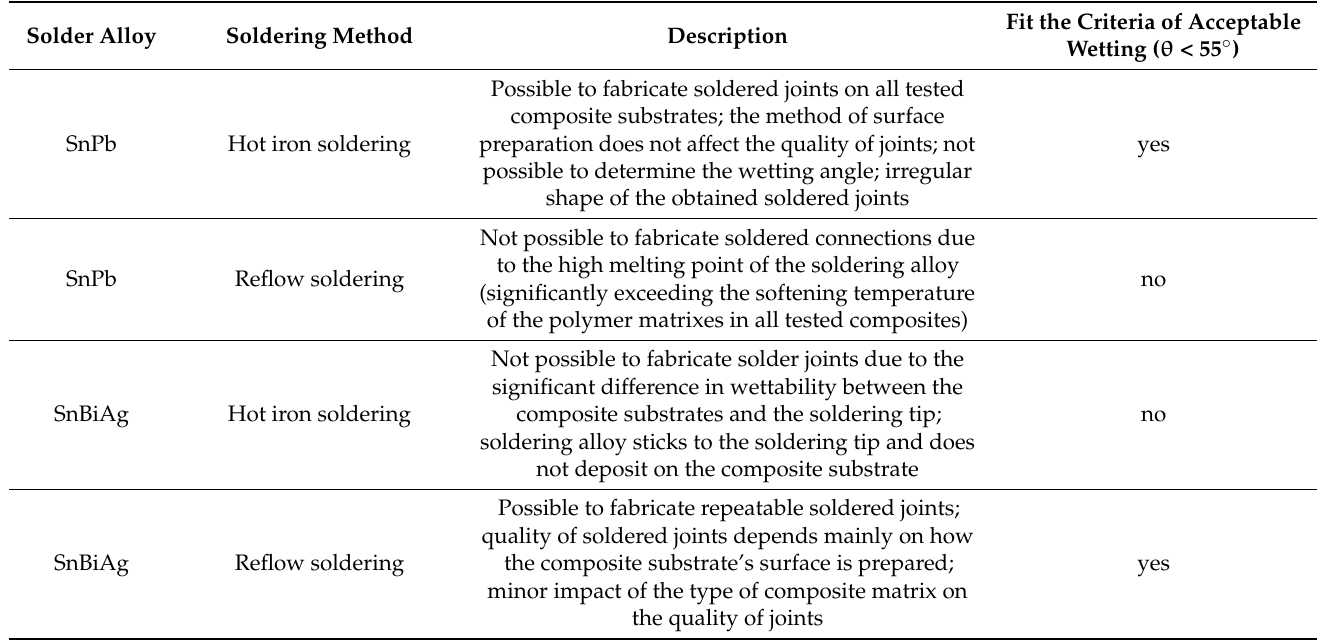
Table 4. Impact of the soldering alloy and soldering method on the quality of the soldered joints. Solder Alloy Soldering Method